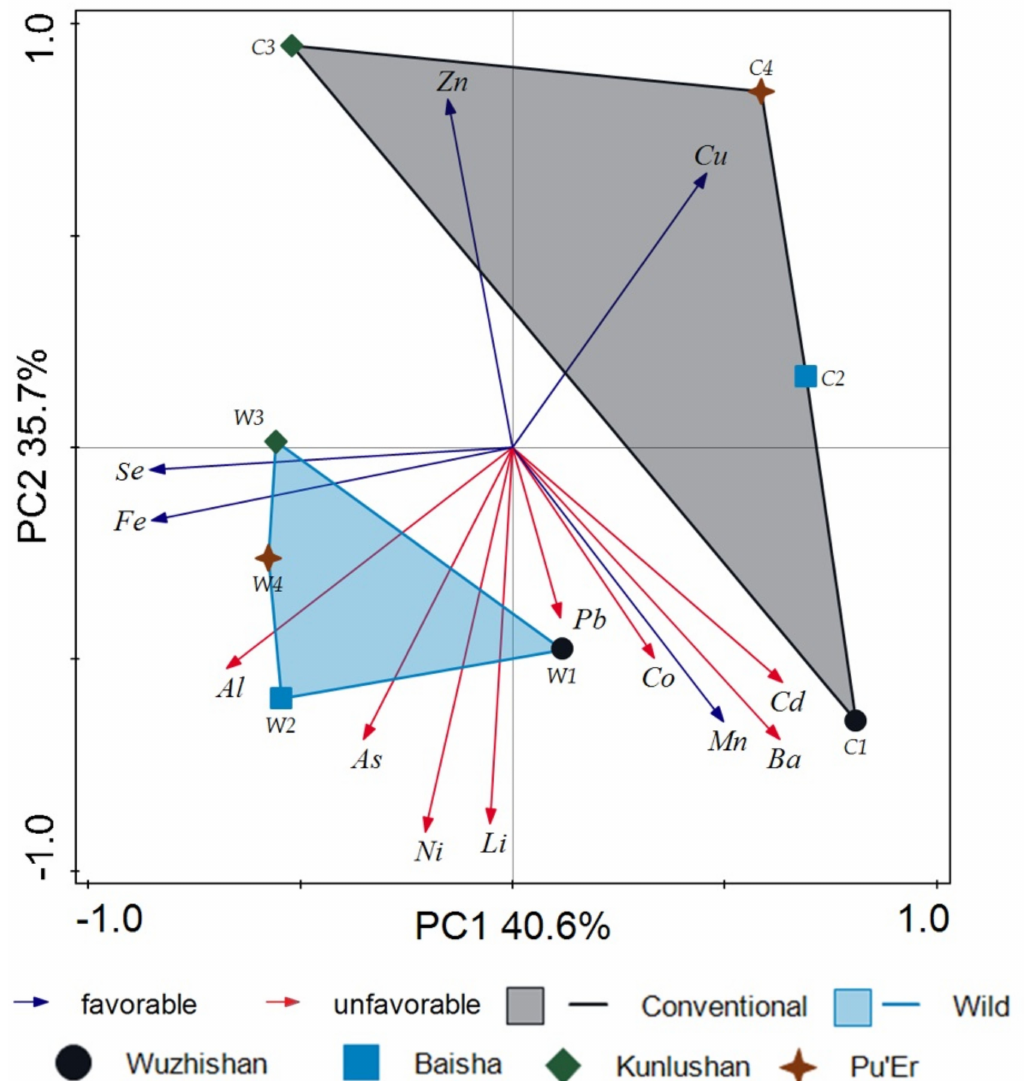
Figure 6. Principal component analysis (PCA) score derived from 14 microelements of 64 tea samples: W1-wild tea, Wuzhishan; W2-wild tea, Baisha; W3-wild tea, Kunlushan; W4-wild tea, Pu’Er; C1-cultivated tea, Wuzhishan; C2-cultivated tea, Baisha; C3-cultivated tea, Kunlushan; C4-cultivated tea,